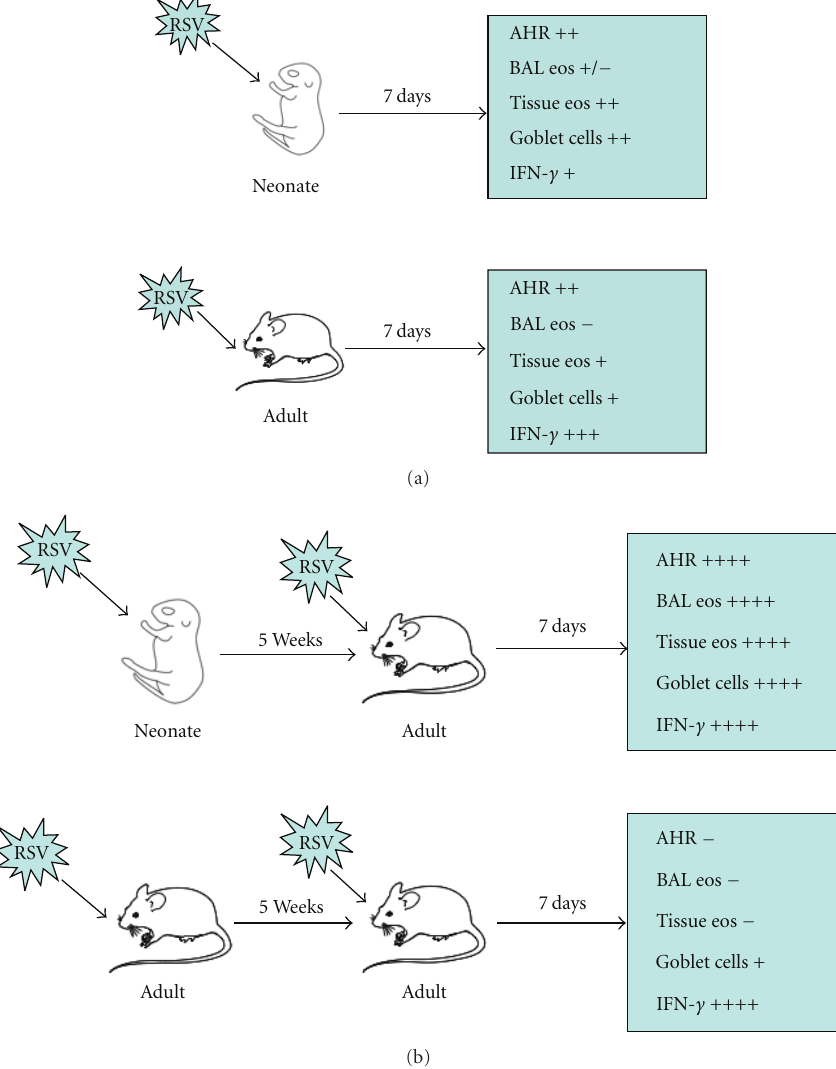
Figure 1: Age-related di ff erences in airway responses. (a) Primary infection, (b) secondary